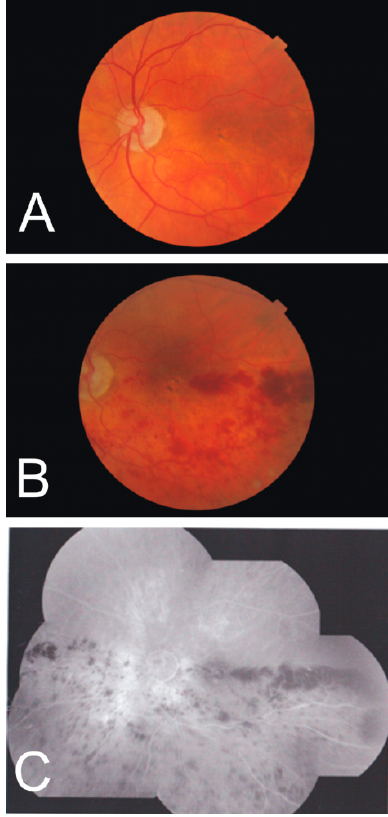
Figure 5. Fundus photographs of a 92-year-old male left eye at the onset of vein occlusion ( A ) and 10 months later ( B ), revealing the development of hemorrhage accumulations somewhat recessing the fovea centralis. ( C ) A photo collage at the second time point shows the symptoms in both the temporal and nasal quadrants of the inferior half.